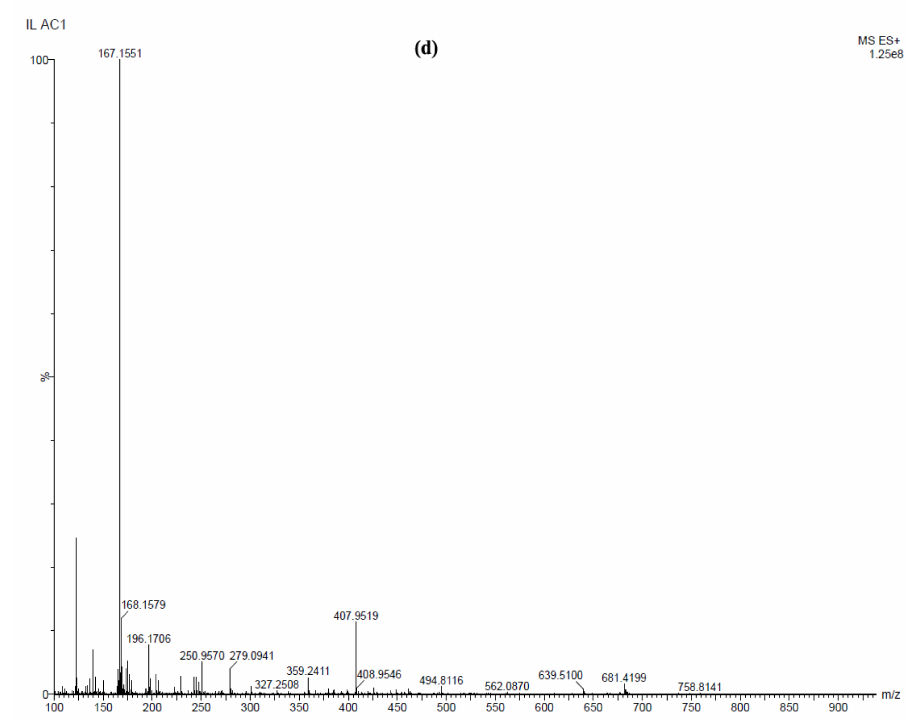
Figure 2. ESI HRMS spectra of a freshly prepared 8 M [HMIm][TFSI]–AlCl 3 solution diluted with acetonitrile. ( a – c ) negative ions mode, ( d ) positive ions